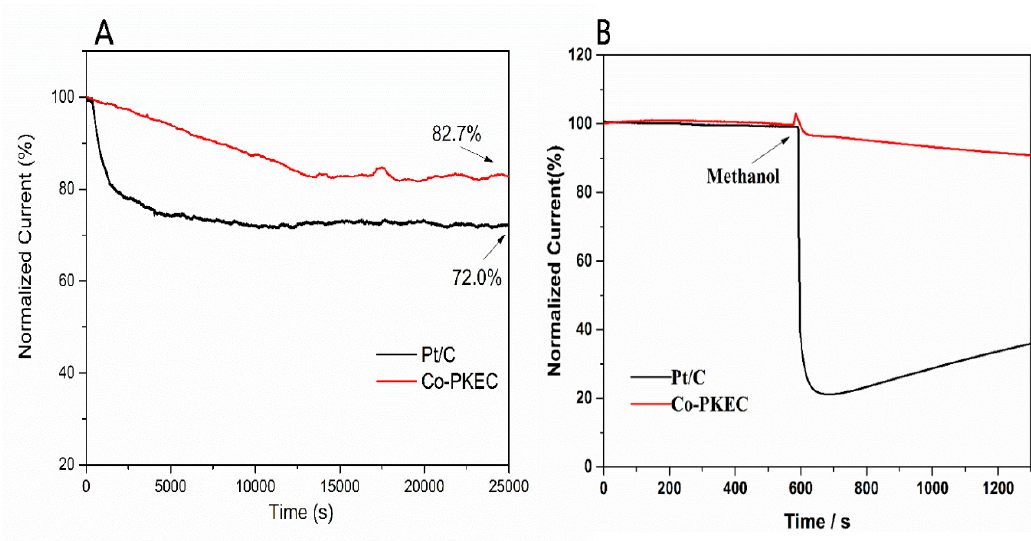
Figure 4. Stability test ( A ) and methanol poisoning resistance test ( B ) of Co-PKEC.